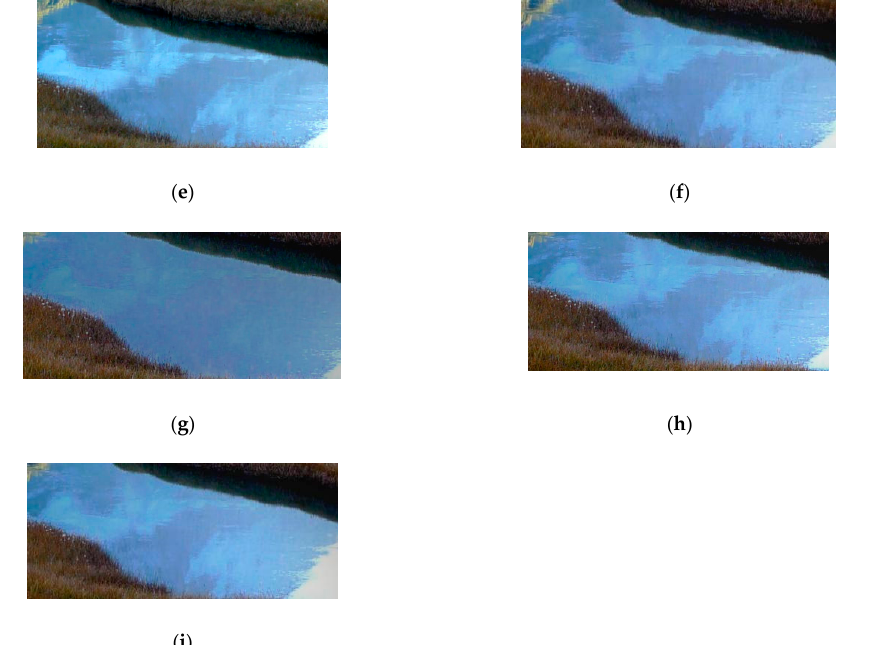
Figure 7. The simulation results of image 2. ( a )-( d ) are the simulated displayed images processed by the four algorithms, the regions in the red circles in ( a )-( d ) are enlarged and shown in ( f )-( i ), ( e ) is the same region of the reference image. ( a ) GFWA, ( b ) LUT, ( c ) FWA, ( d ) ISFLA, ( e ) Reference